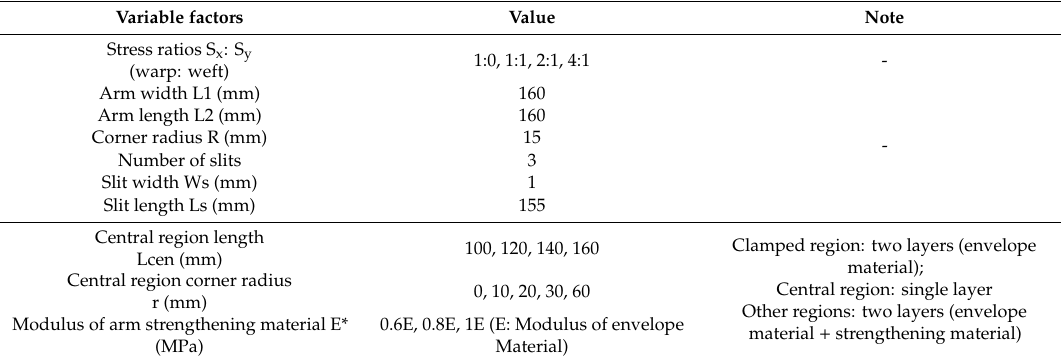
Table 2. Analysis conditions for finite element model (FEA) (underlined: standard